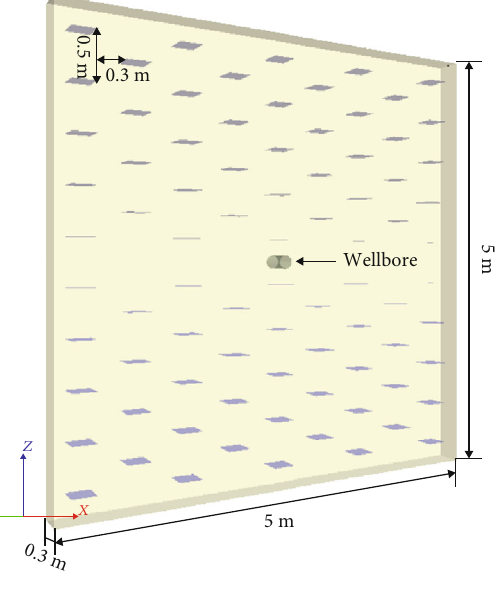
Figure 7: Setup of the base